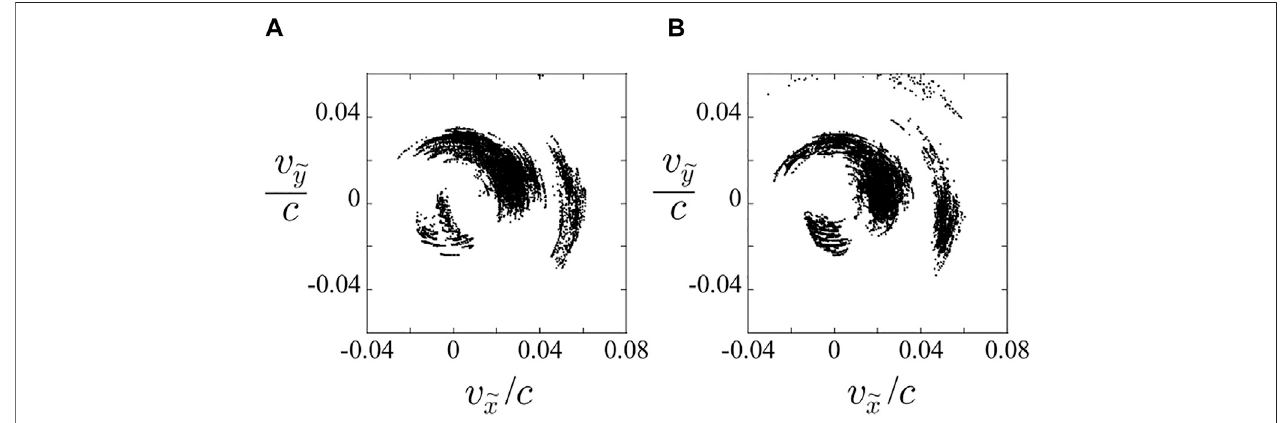
FIGURE 11 | Velocities ( v ~ x , v ~ y ) of the ions inside small areas whose locations are the same as (A) : the boxed area (d1) and (B) : the boxed area (d2) represented in Figure 5C , respectively.